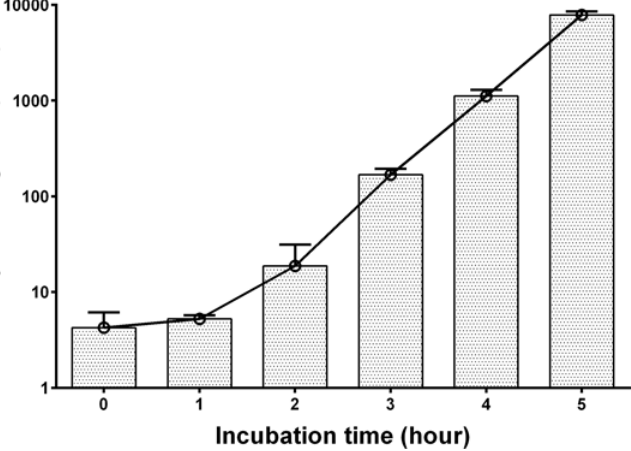
Fig 2. Growth of S. Paratyphi A Strain NVGH308 in TSB — 2.4% Ox Bile – 20% Blood Culture Medium. An average of 4 CFU of bacteria was inoculated into 10 ml of TSB containing 2.4% ox bile and 20% blood, and incubated at 37°C with shaking at 220 RPM for up to 5 hours. Bacterial counts were determined every hour by plating onto TSA plates. The CFU count shown represents the mean ± SD of three independent inoculated blood